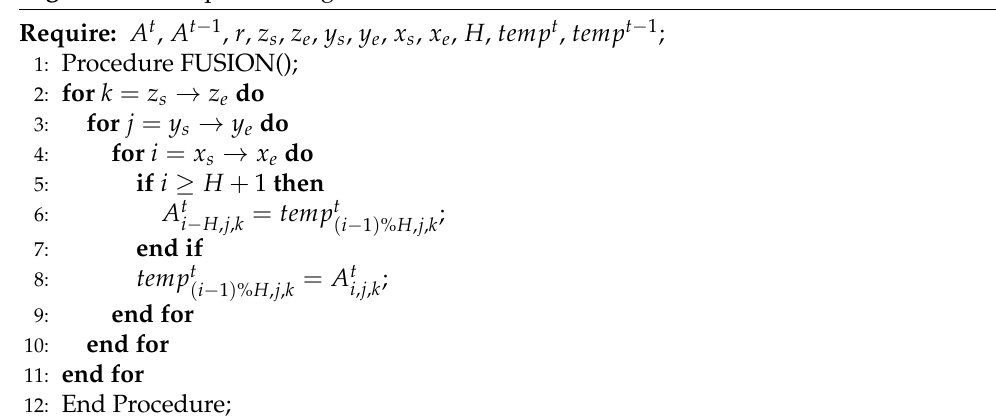
Algorithm 3 Loop fusion